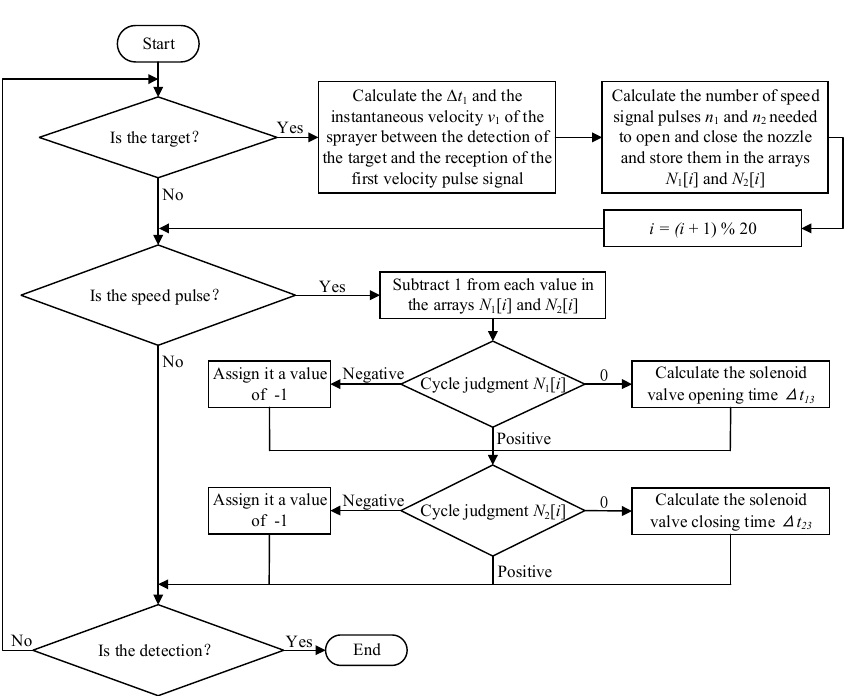
Figure 3. Flow chart of orchard tree target single-side detection.